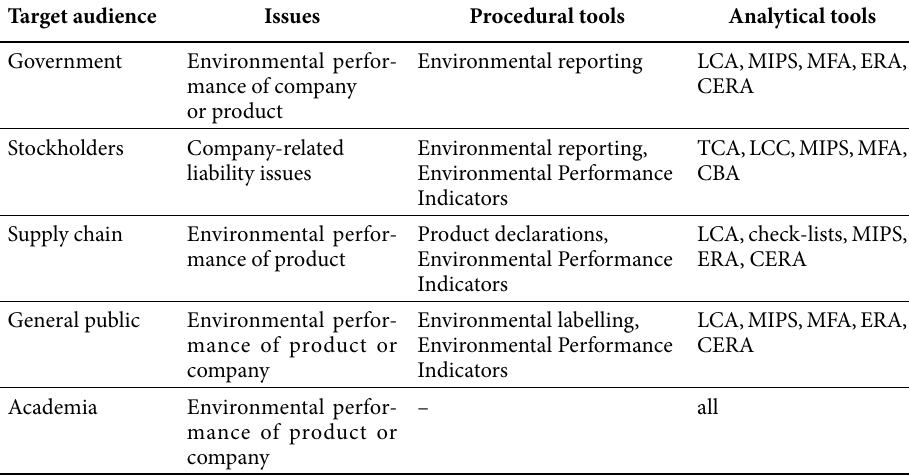
Fig. 5. Procedural and analytical tools to tackle environmental performance issues in selected target audiences